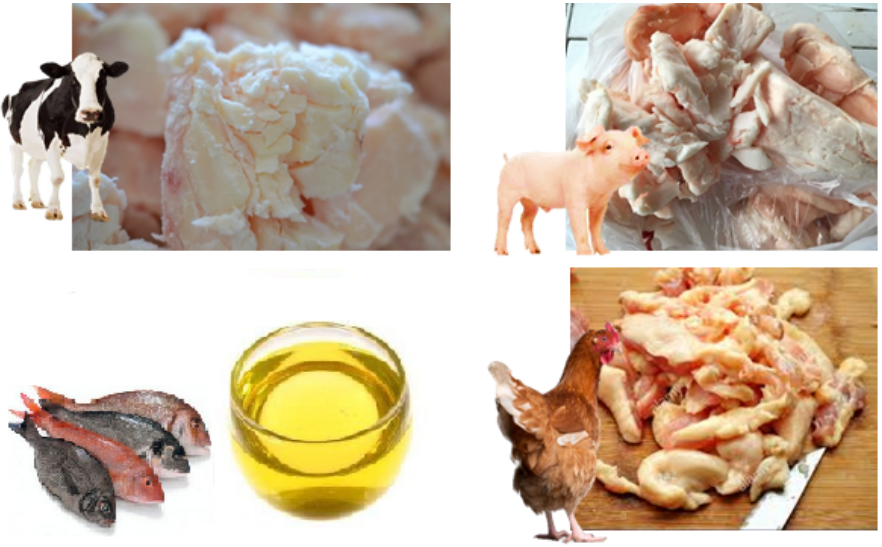
Figure 5. Tallow, lard, fish oil, and poultry